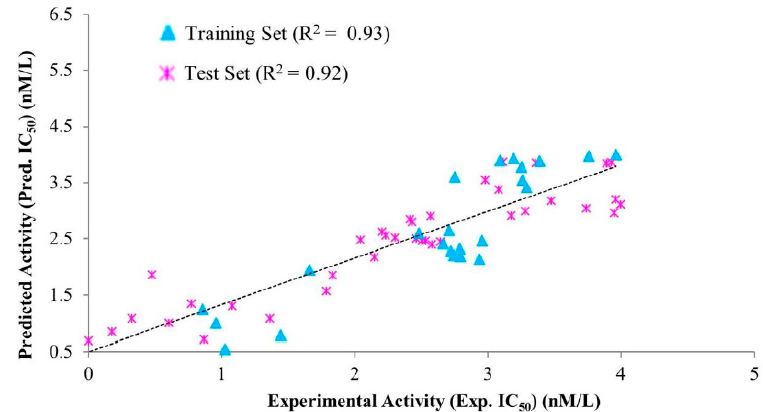
Figure 4. Correlations between the experimental activities and the predicted activities using Hypo1 with the training set compounds and test set compounds. Hypo1 observed strong correlation between the predicted activities of training set and test set compounds.